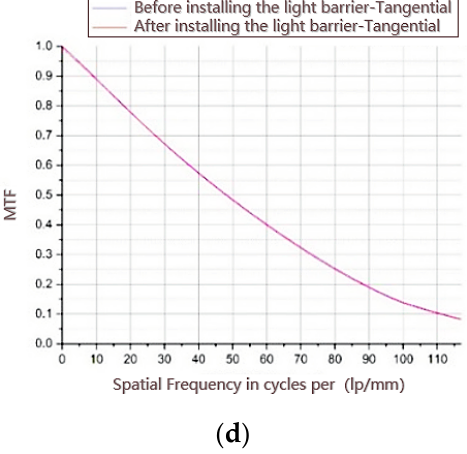
Table 9. Statistical table of MTF changes in different fields of view in the tangential direction.